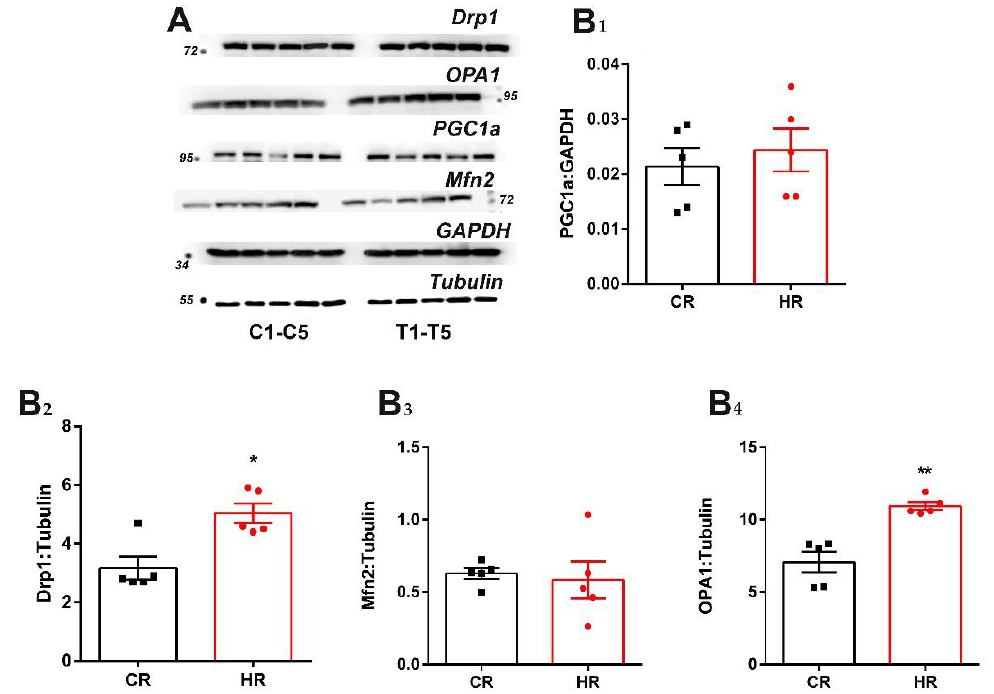
Figure 4. Immunoblotting analysis of the mitochondrial dynamics and biogenesis proteins in heart tissue of control and hyperthyroid rats: ( A ) representative Western blot of Drp1, OPA1, Mfn2, PGC1 α , C 1 -C 5 -CR and T 1 -T 5 -HR; ( B ) relative levels of appropriate proteins with respect to the loading control (GAPDH or tubulin). CR, control; HR, hyperthyroidism. * p < 0.05 and ** p < 0.02, as compared with the control data (n = 5).